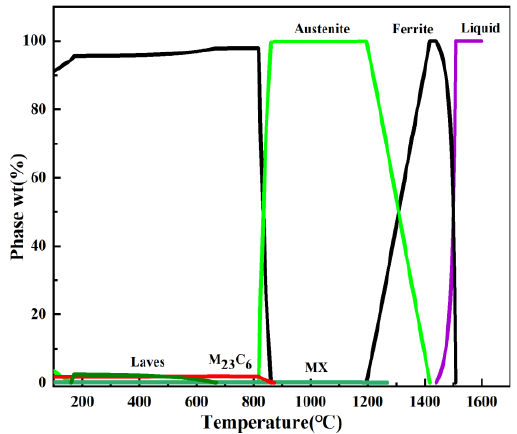
Figure 7. Balanced phase diagram.